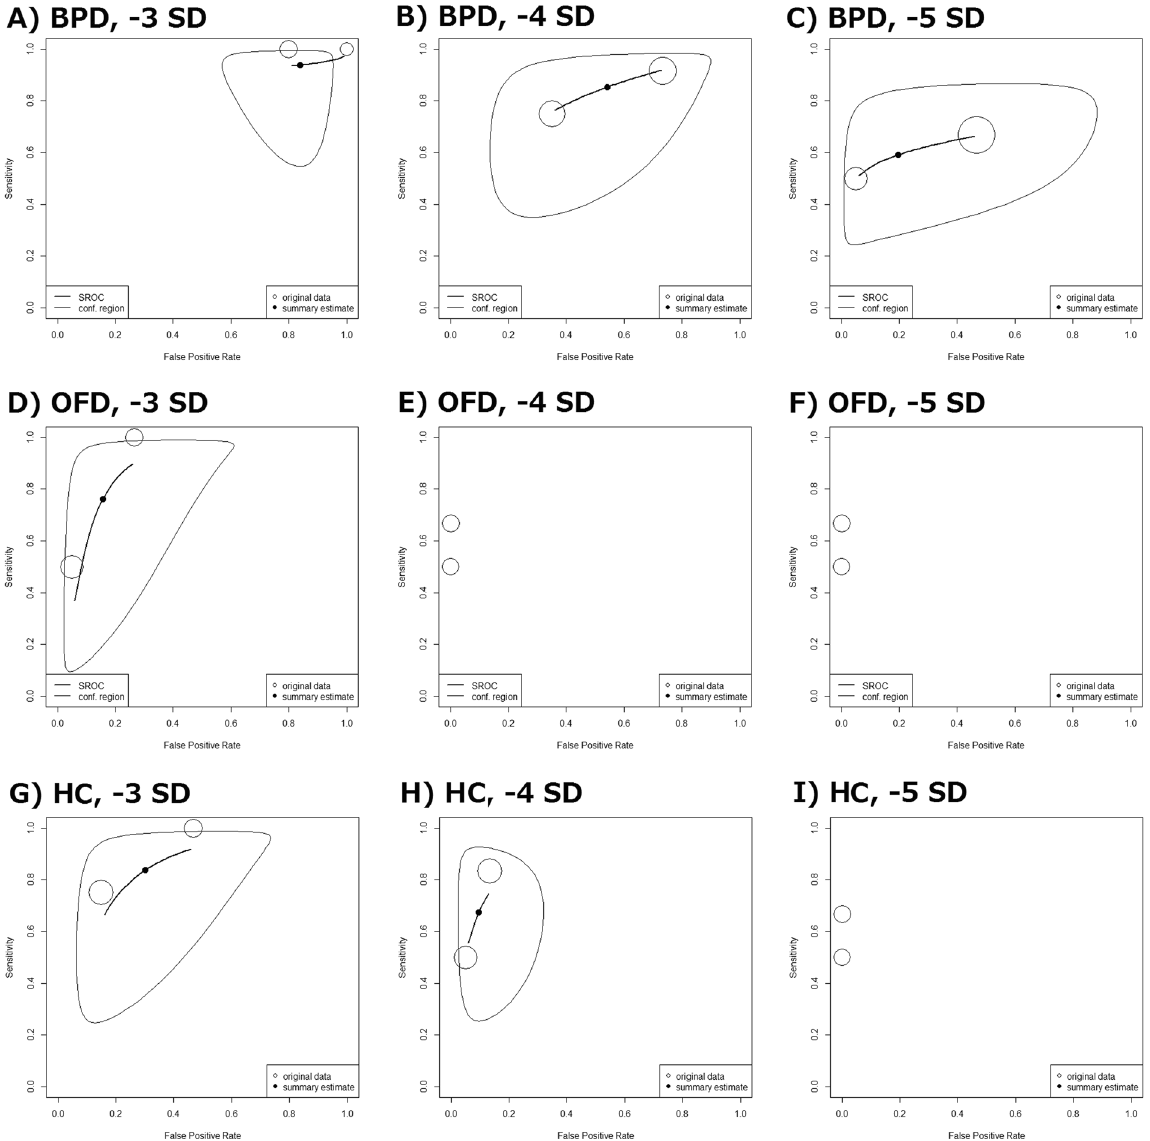
Figure 2. Hierarchical summary receiver operating characteristics (HSROC) curves for A–C ) BPD, D–F ) OFD and G–I ) HC at 3, 4 and 5 SD below the mean. The size of each circle reflects weight, not confidence region. (Open arrow: Two circles had exactly same accuracy and weight. Filled arrow: Three circles had exactly same accuracy and